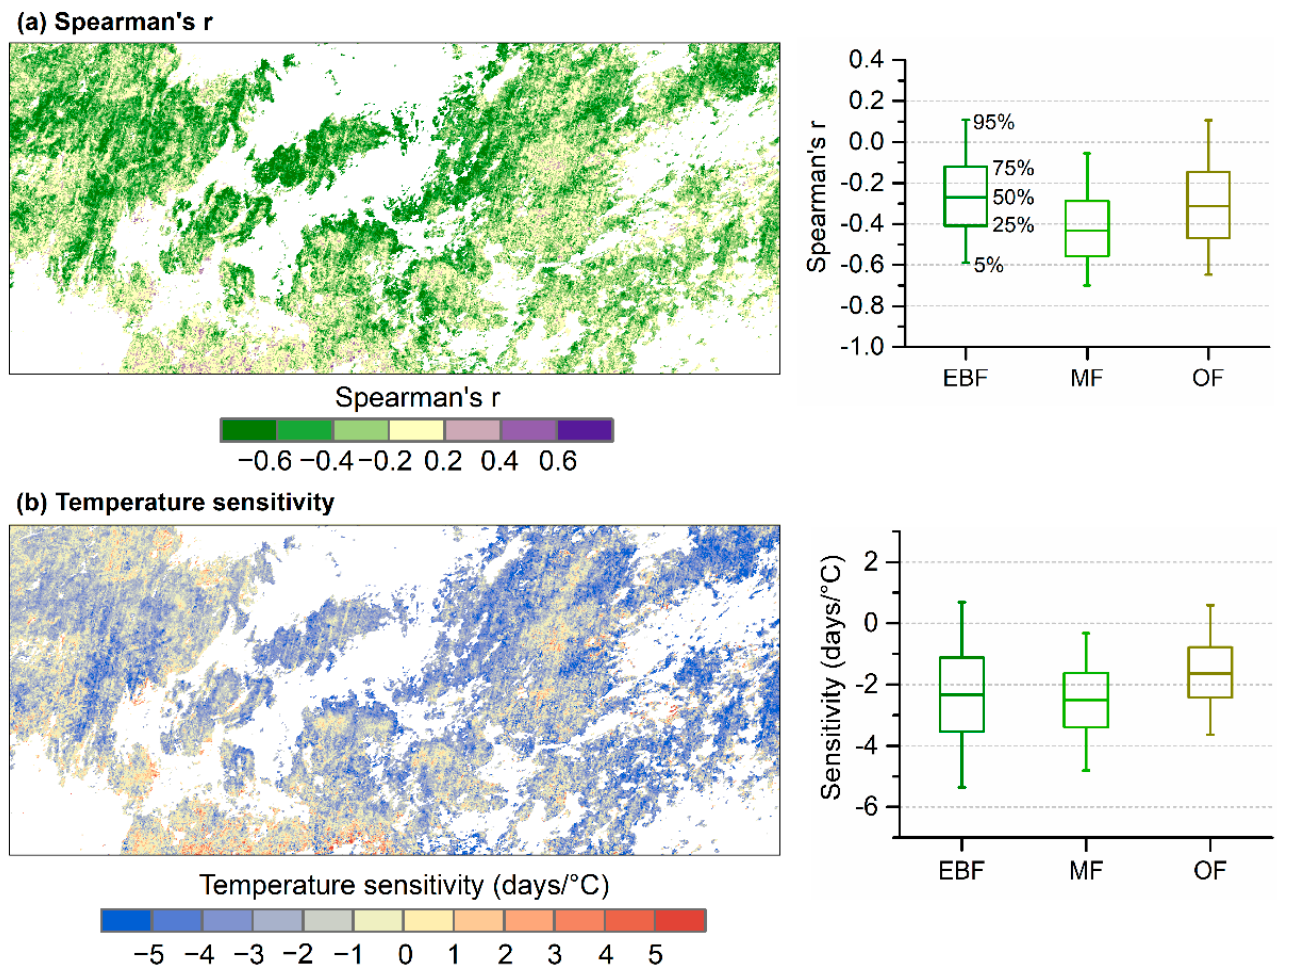
Figure 7. Relationship between SOS and mean air temperature in February-March (T FM ). ( a ) Spear- man partial correlation coefficient (Spearman’s r) by controlling total precipitation and radiation.